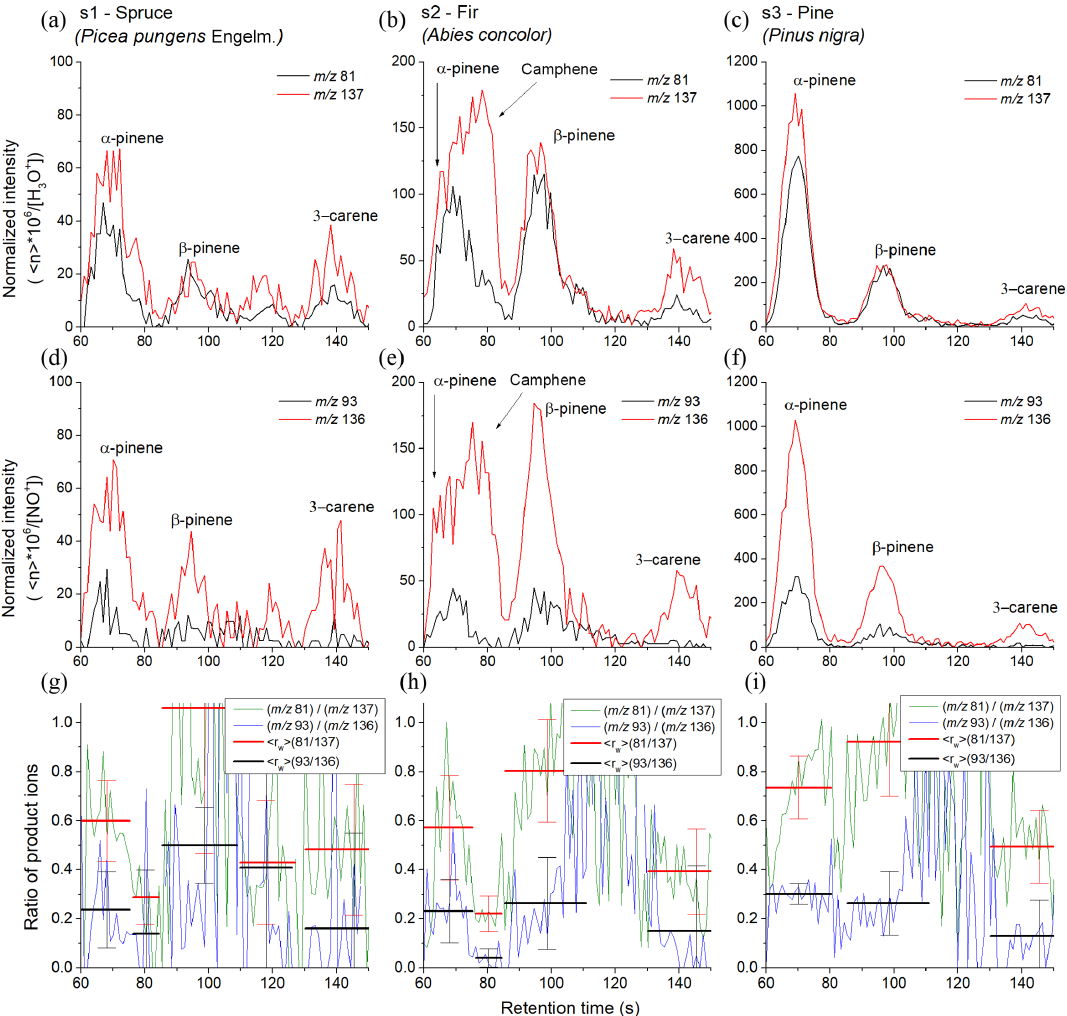
Figure 6. SIFT-MS-selected ion mode, fast GC and SIFT-MS chromatograms for monoterpene emissions from pine tree samples (s1, s2 and s3) obtained using the MXT-Volatiles column. The upper and lower rows were obtained using H 3 O + and NO + reagent ions, respectively. The signal intensities are the analyte ion count rates normalized to a reagent ion count rate of 10 6 s − 1 . The black and red curves stand for monitored ions C 6 H + ( m/z 81) and C 10 H + ( m/z 137) for H 3 O + reagent ions and C 7 H + ( m/z 93) and C 10 H + ( m/z 136) for NO + reagent 9 17 9 16 ions, respectively. The last row shows calculated ratios of product ions r i for both reagent ions (green and blue curves) and for calculated peaks areas r w (red and black).